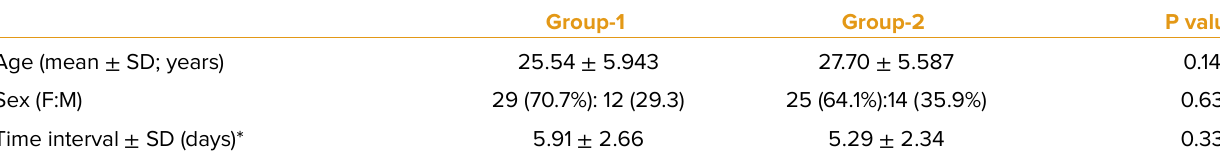
Table 2. Demographics of patients with retrobulbar optic neuritis